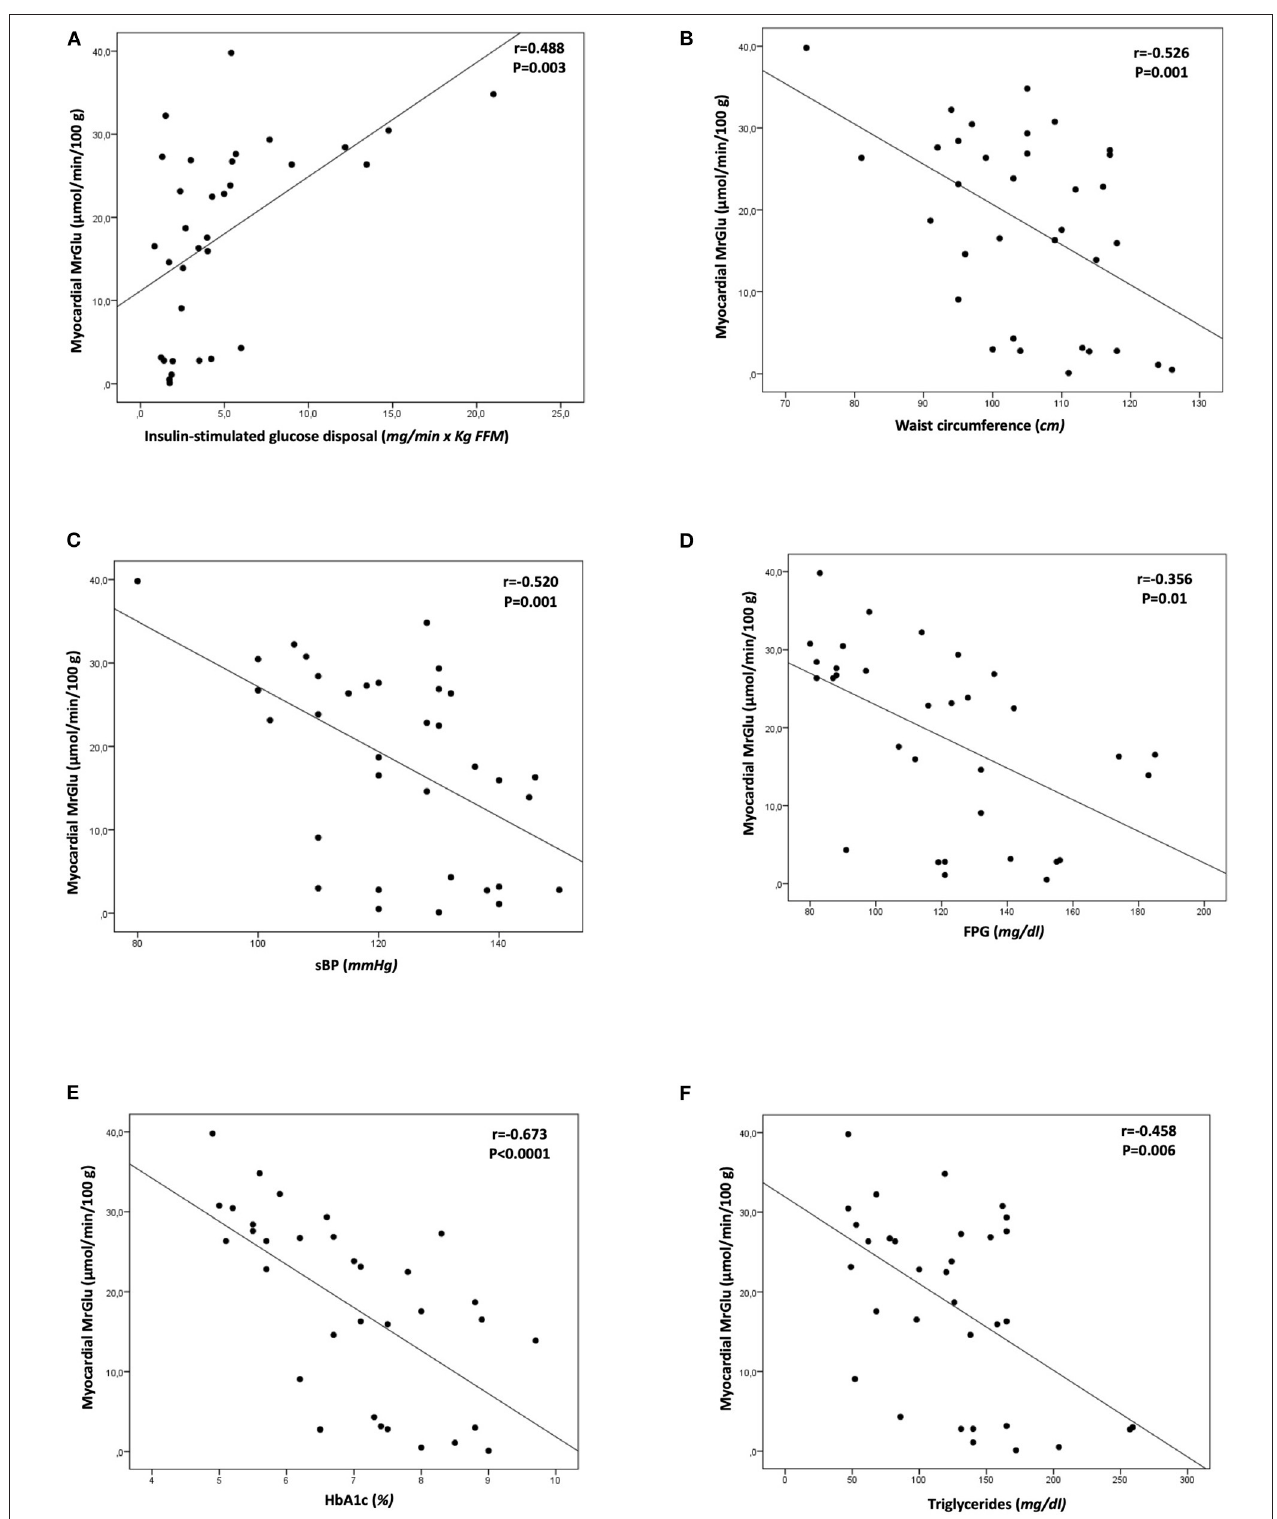
FIGURE 2 | Univariate correlations between myocardial glucose metabolic rate and insulin-stimulated glucose disposal (A) , waist circumference (B) , systolic blood pressure (C) , fasting plasma glucose (D) , HbA1c (E) , triglycerides (F) . MrGlu, glucose metabolic rate; sBP, systolic blood pressure; FPG, fasting plasma glucose.